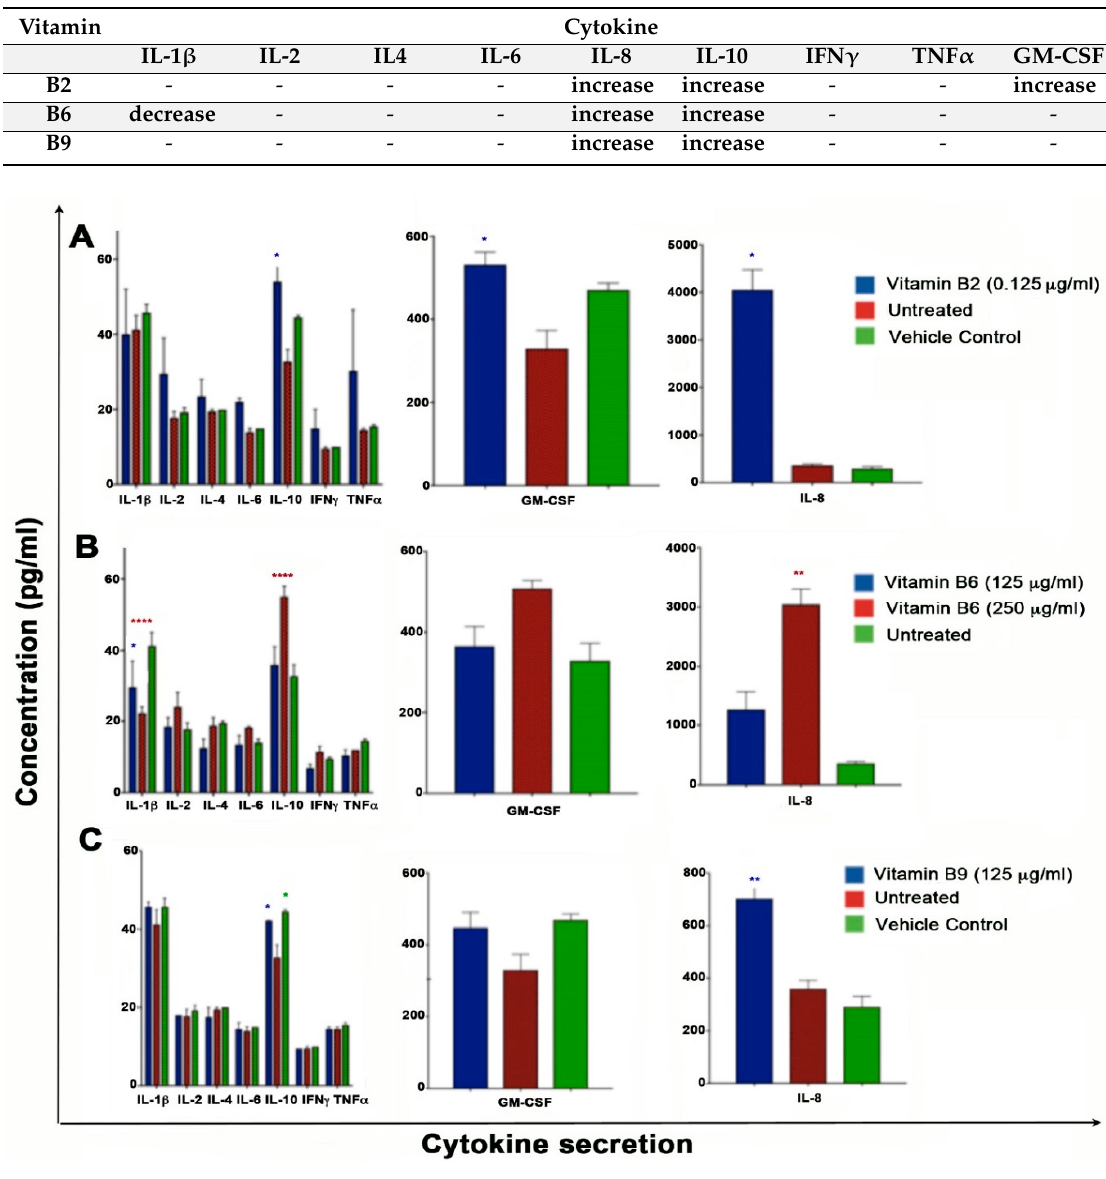
Table 1. Summary of cytokine secretion by promonocytic U937 cell line.